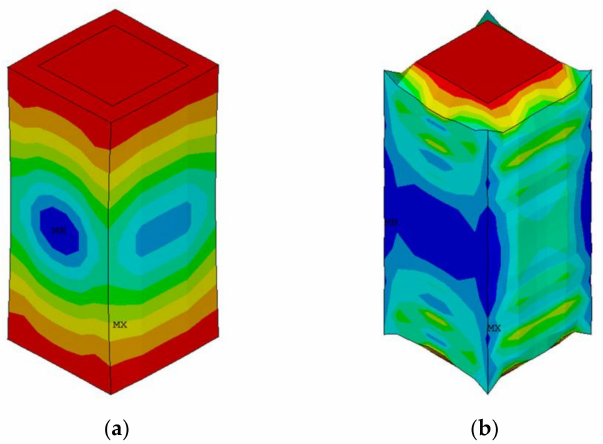
Figure 3. Displacement deformation diagram of each pure epoxy resin ( a ) and silicone rubber ( b ) composite element.